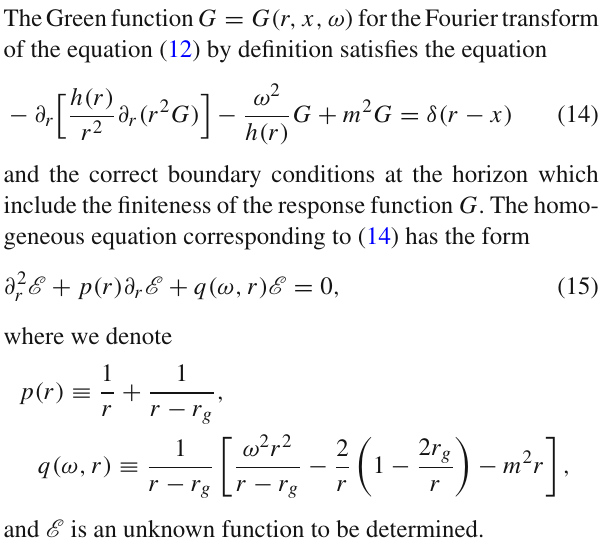
We use the equation (12) because its homogeneous solu- derivative of a linear combination of the functions (6)